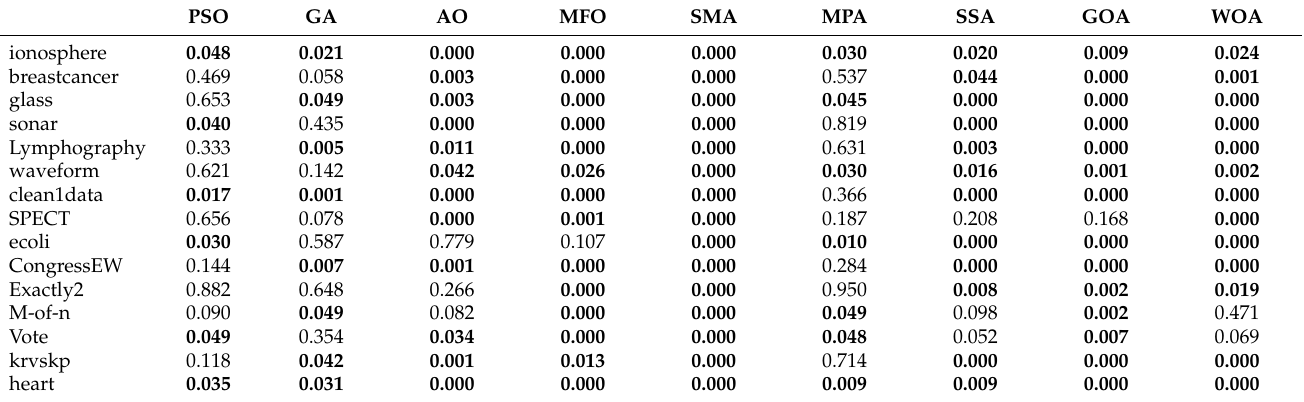
Table 14. Results of the Wilcoxon rank sum test for all methods.